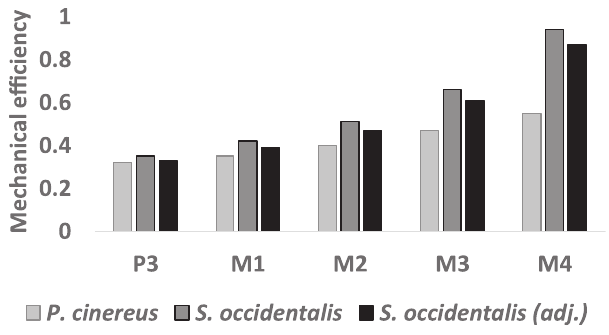
Fig 3. Mechanical efficiency (bite reaction force/total muscle force) at each biting